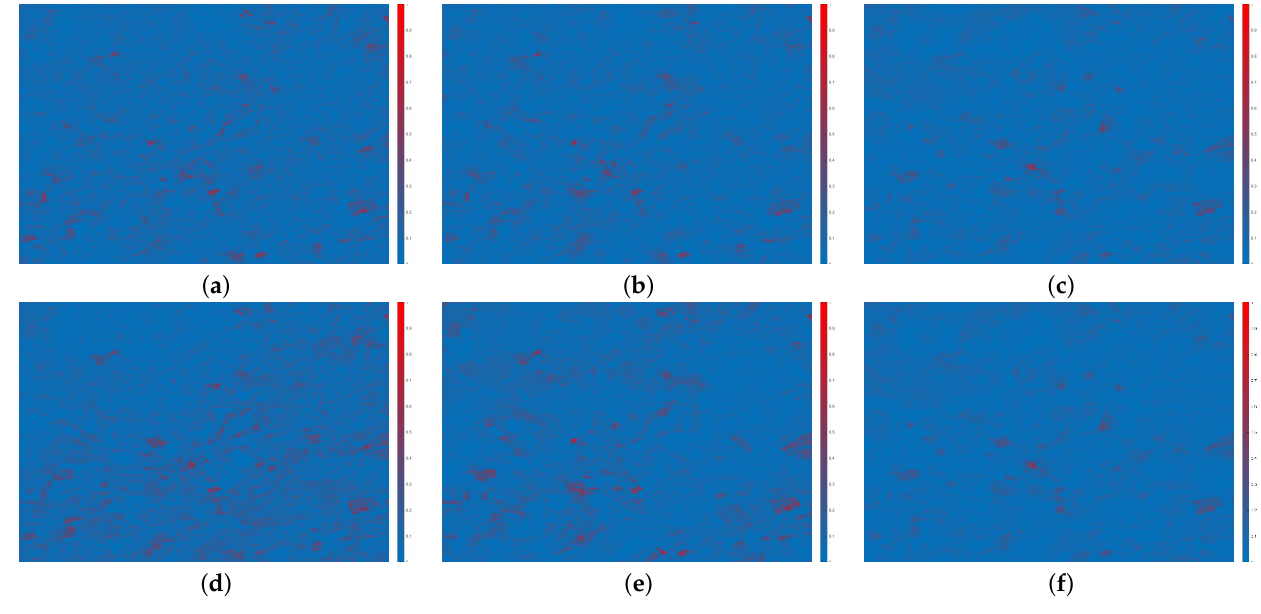
Figure 11. Comparison of the residual diagrams produced by various methods for the LGC dataset on 2 March 2005. ( a ) STARFM. ( b ) FSDAF. ( c ) DCSTFN. ( d ) EDCSTFN. ( e ) AMNet. ( f ) The proposed